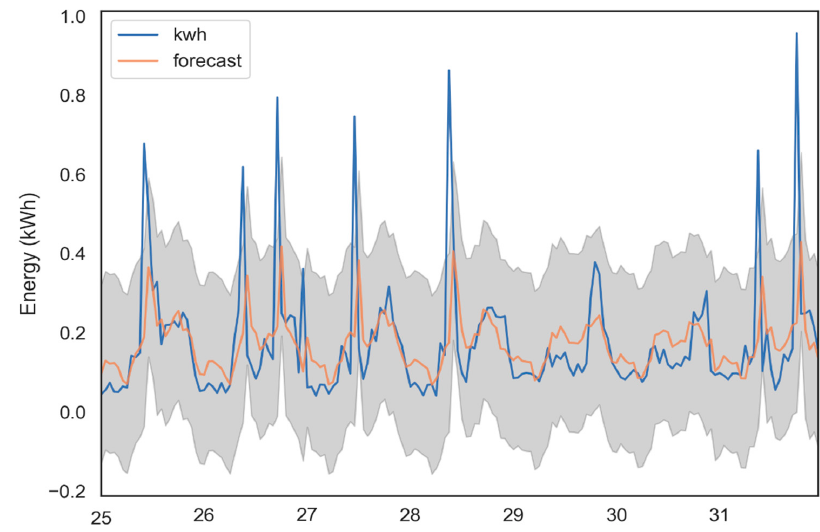
Figure 12. SARIMA dashboard forecasting: energy consumption hourly forecasting.